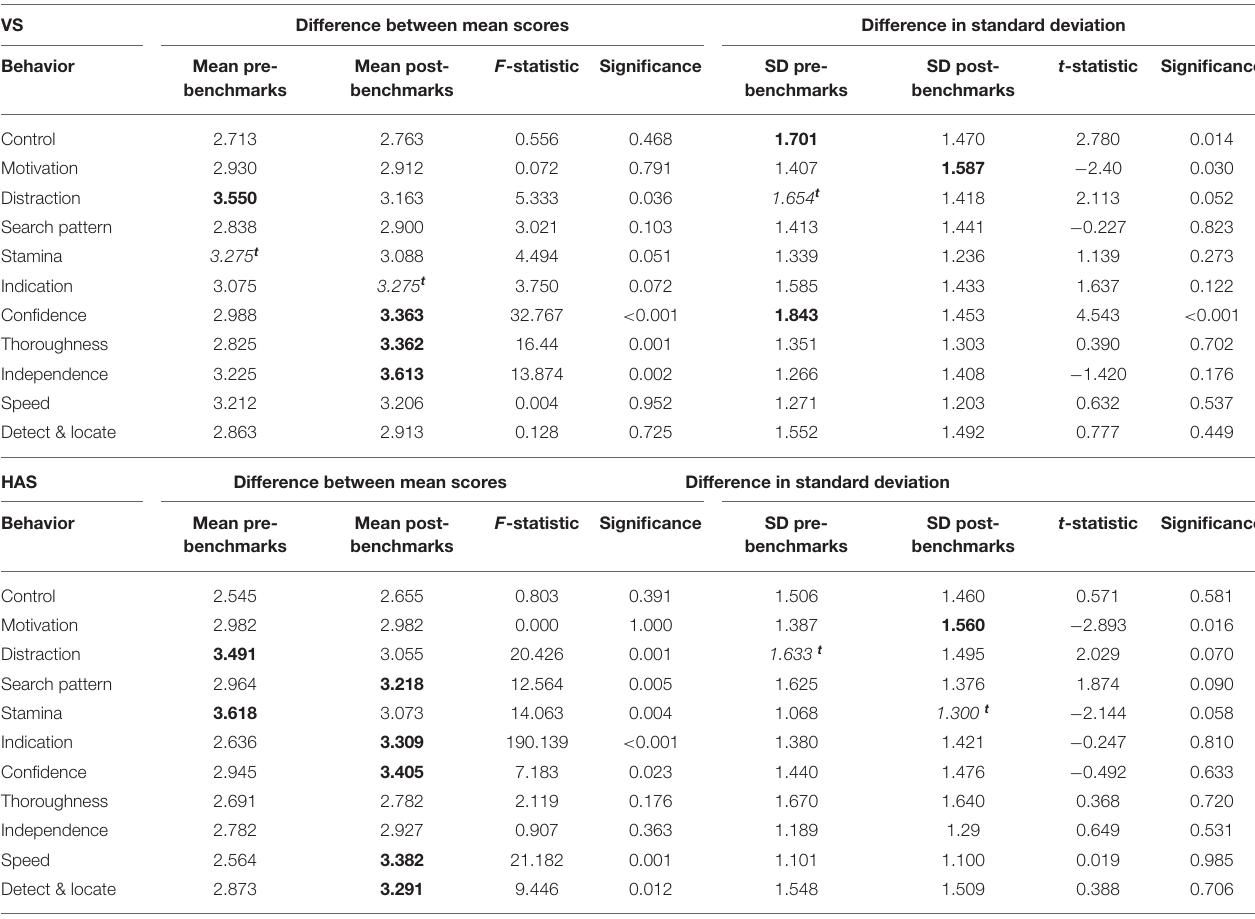
TABLE 3 | Difference in mean scores and standard deviation (within observer) between pre- and post-benchmark conditions for each performance trait (Univariate GLM, paired t -test); where the difference is significant the higher mean value is shown in bold and trends t (also in